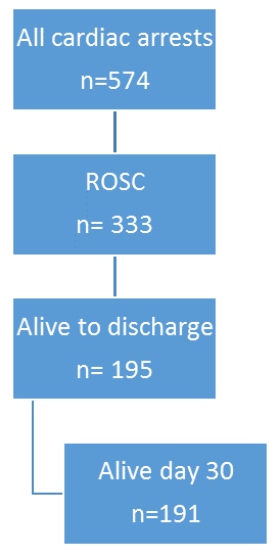
Figure 1. Outcome of resuscitation of in-hospital cardiac arrest. ROSC, return of spontaneous